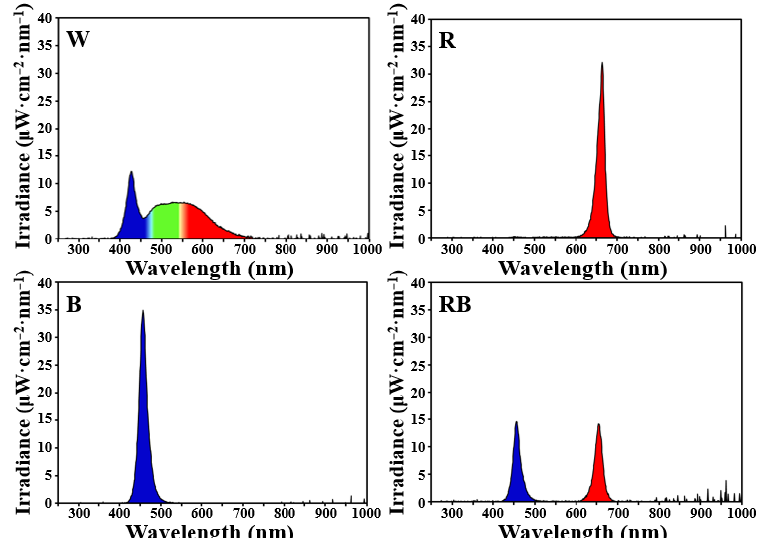
Figure 1. Spectral qualities of the different light sources used in the experiment: W, white LED; R, red LED; B, blue LED; and RB, combined red and blue LEDs in a 1:1 ratio.